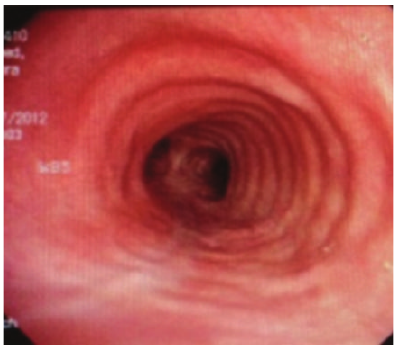
Figure 1: Preoperative CT scan showing deviation and compression of trachea.